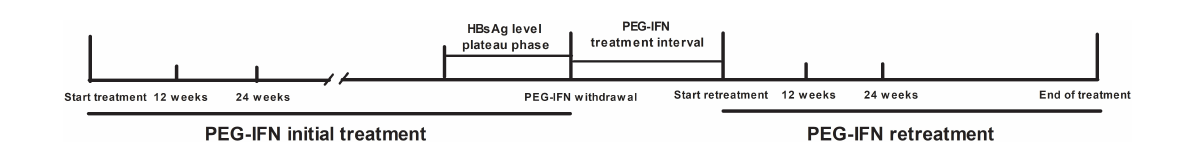
FIGURE1 Patient treatment and observation procedures.